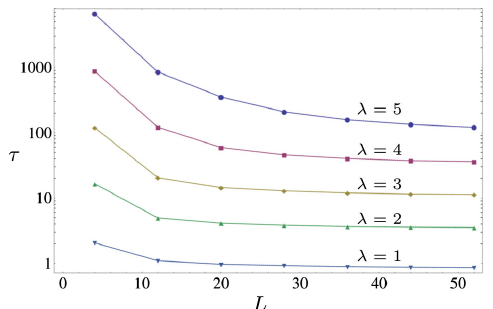
FIG. 9. Average lifetimes τ of the logical qudit with logical ~ Z ~ X operators 1 and 1 as a function of code size L for 5. Each data point represents 10 4 experiments. The lifetime is defined as the number of Metropolis steps until the first logical operator detects an error, divided by the number of spins in the